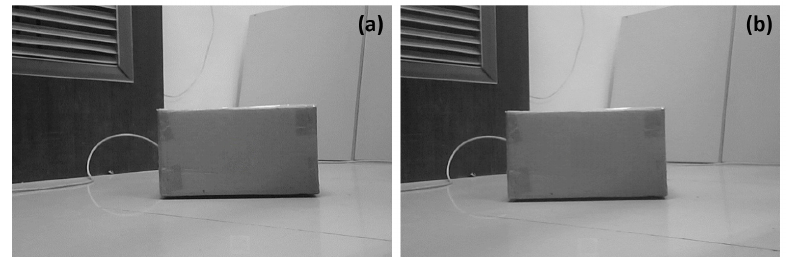
Figure 16. Two images of an obstacles identified acquired by robot binocular vision system for obstacle position calculation. ( a ) An obstacle image acquired by the left hand-side camera; ( b ) An obstacle image acquired by right hand-side camera.